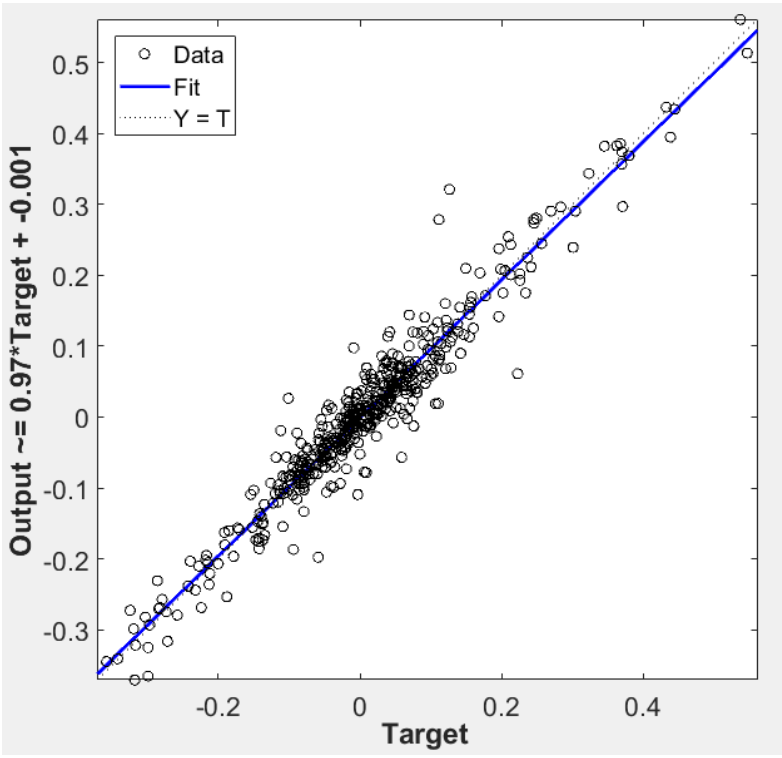
Figure 16. Regression plot for the validation of a NN model of Δ P with Δ t = 60 s step and ROI radius = 250 pixels.